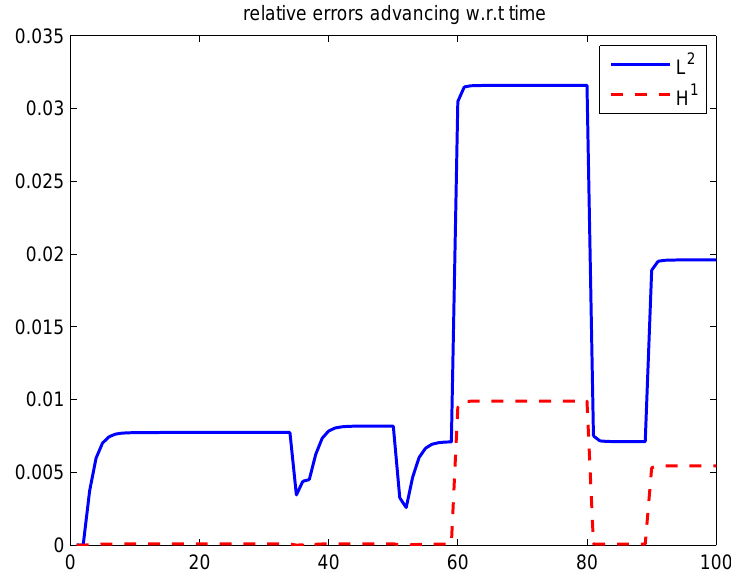
Figure 6. Injection rate schedules for training and test models.